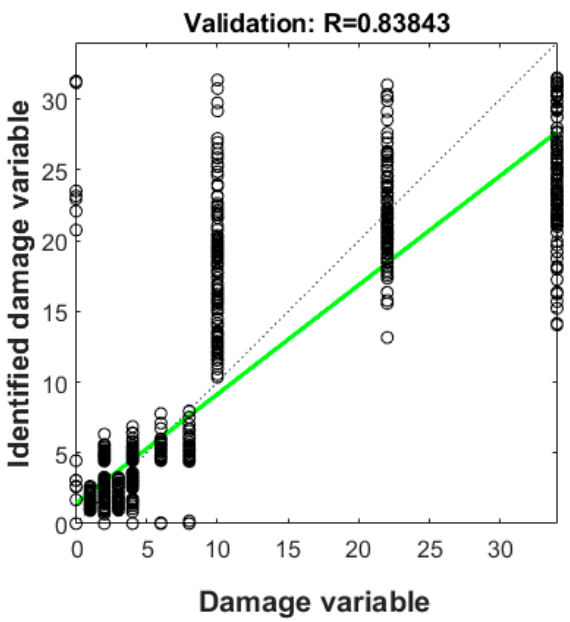
Figure 8. Overall damage identification accuracy.